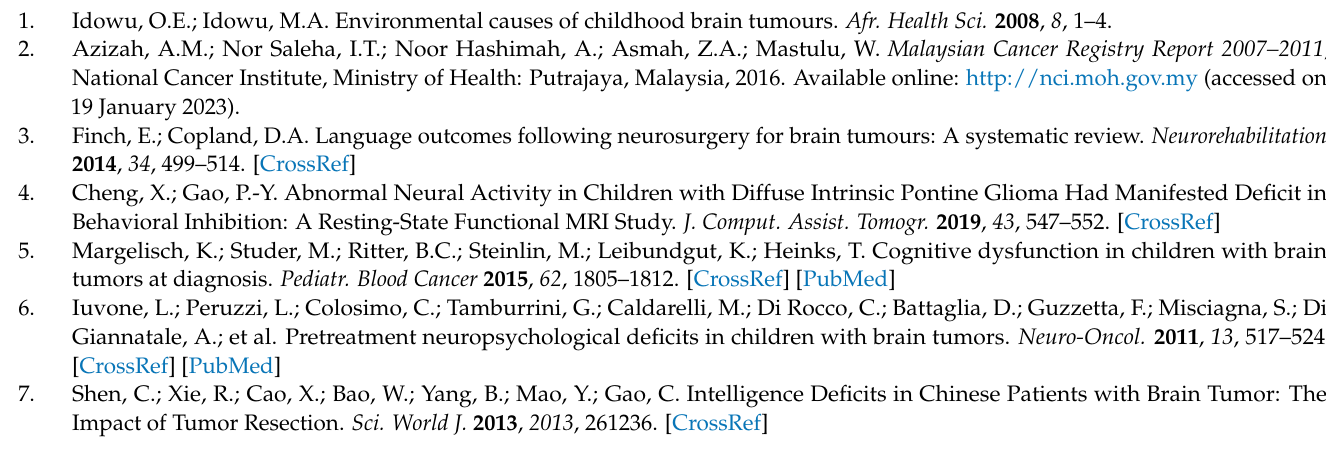
Table S2: PRISMA 2020 for Abstract Checklist [144]; Table S3: Advanced Search Keyword chain in PubMed; Table S4: Quality Assessment of Selected Studies by NHLBI,